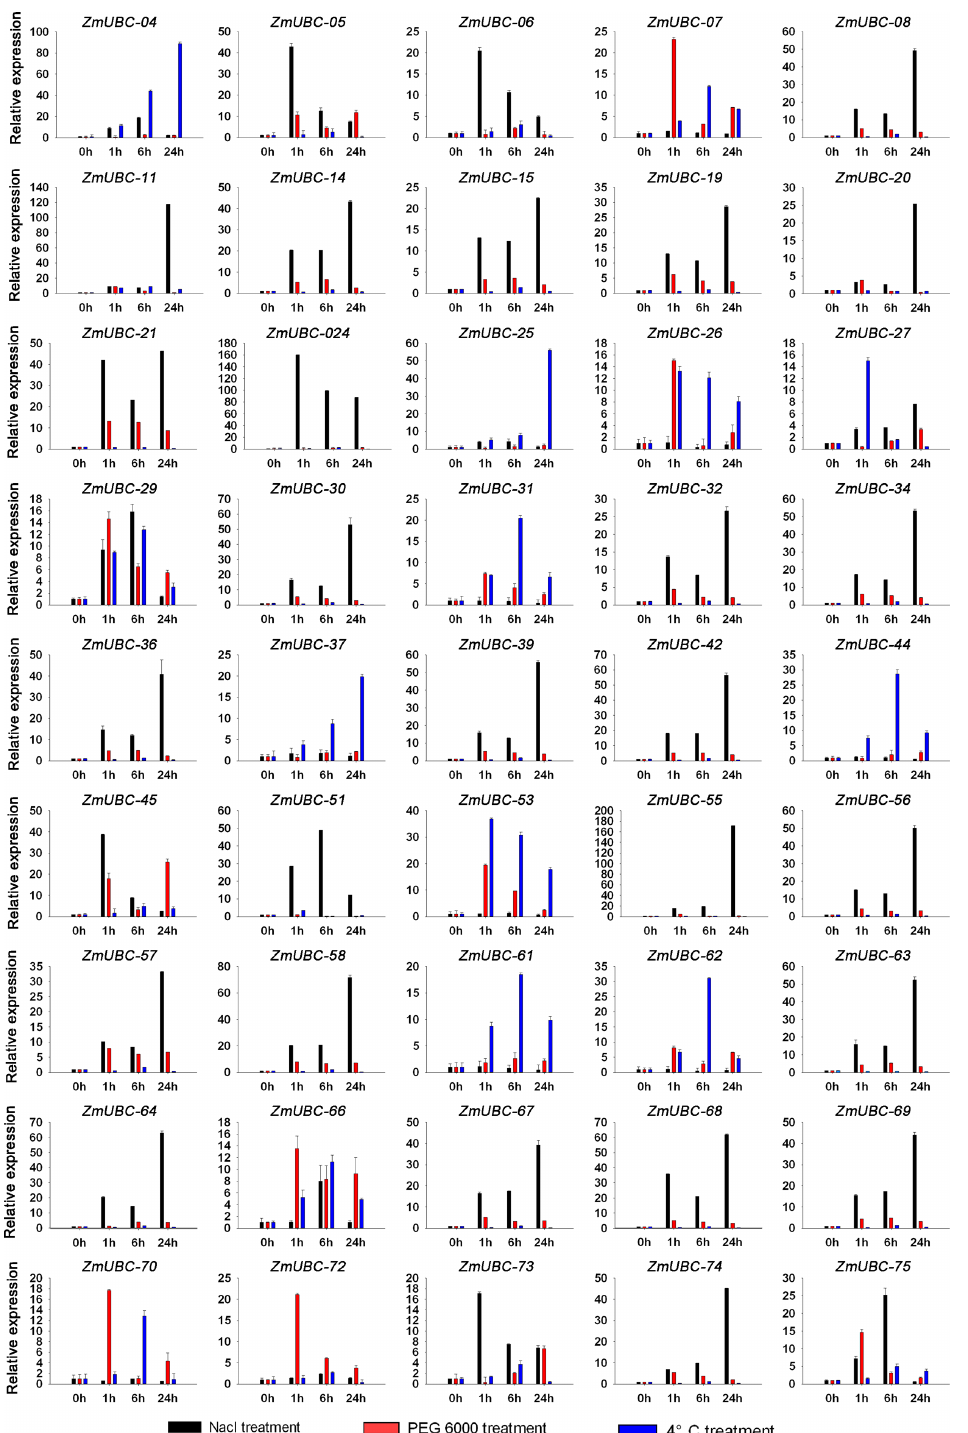
Fig 5. Differential expression levels of ZmUBC genes following NaCl, PEG 6000, and 4°C treatment. The X-axis indicates time course/treatment and the Y-axes are scales of relative expression levels. The maize actin gene was used as internal control. The presented data are representative of three independent